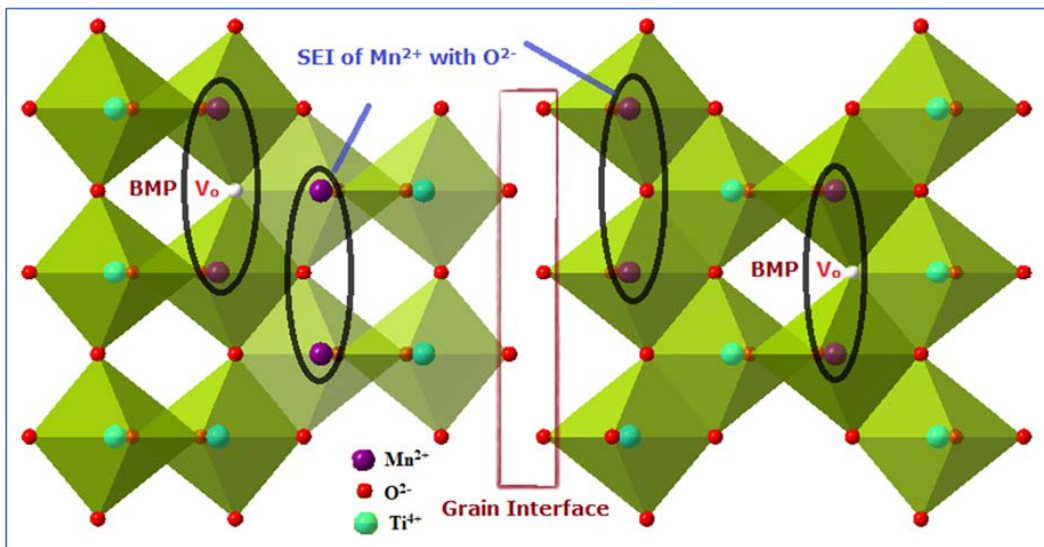
Figure 5. Schematic depicting two grains of Mn-doped TiO 2 (anatase) separated by grain boundary with bound magnetic polarons (BMP) among Mn 2 + –V o –Mn 2 + and superexchane interactions (SEI) of Mn 2 + with O 2 − .